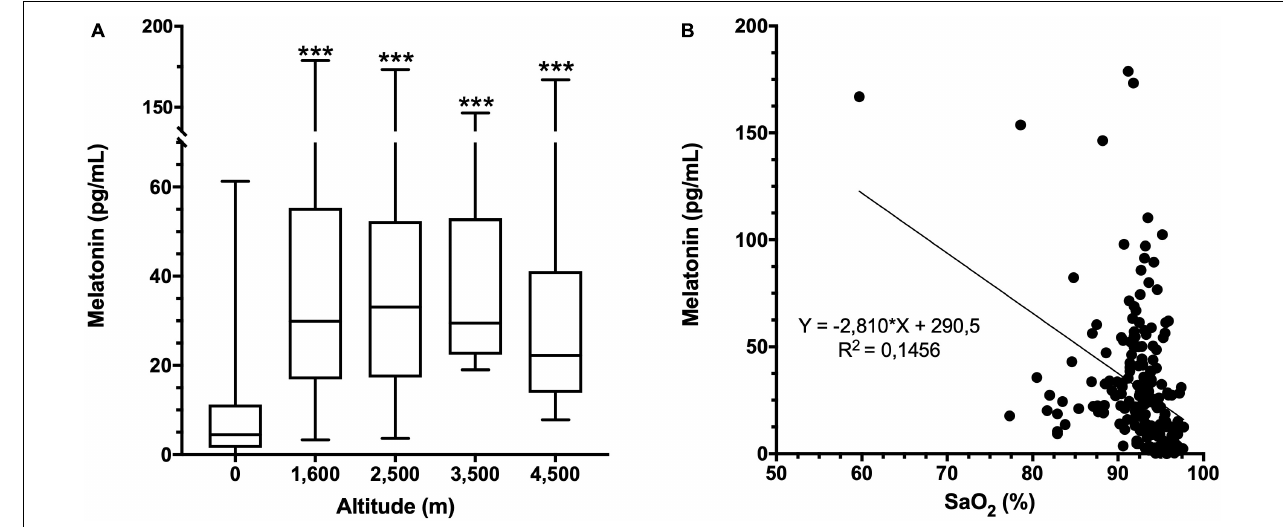
FIGURE 3 | Melatonin concentration and altitude. (A) Melatonin concentration in plasma at each altitude. Data are presented as a box-and-whisker plot. Significant differences: *** p < 0.001 compared to the population at 0 m. (B) Correlation of melatonin concentration with oxygen saturation (SaO 2 ) at all altitudes. Equation and the linear regression R 2 are